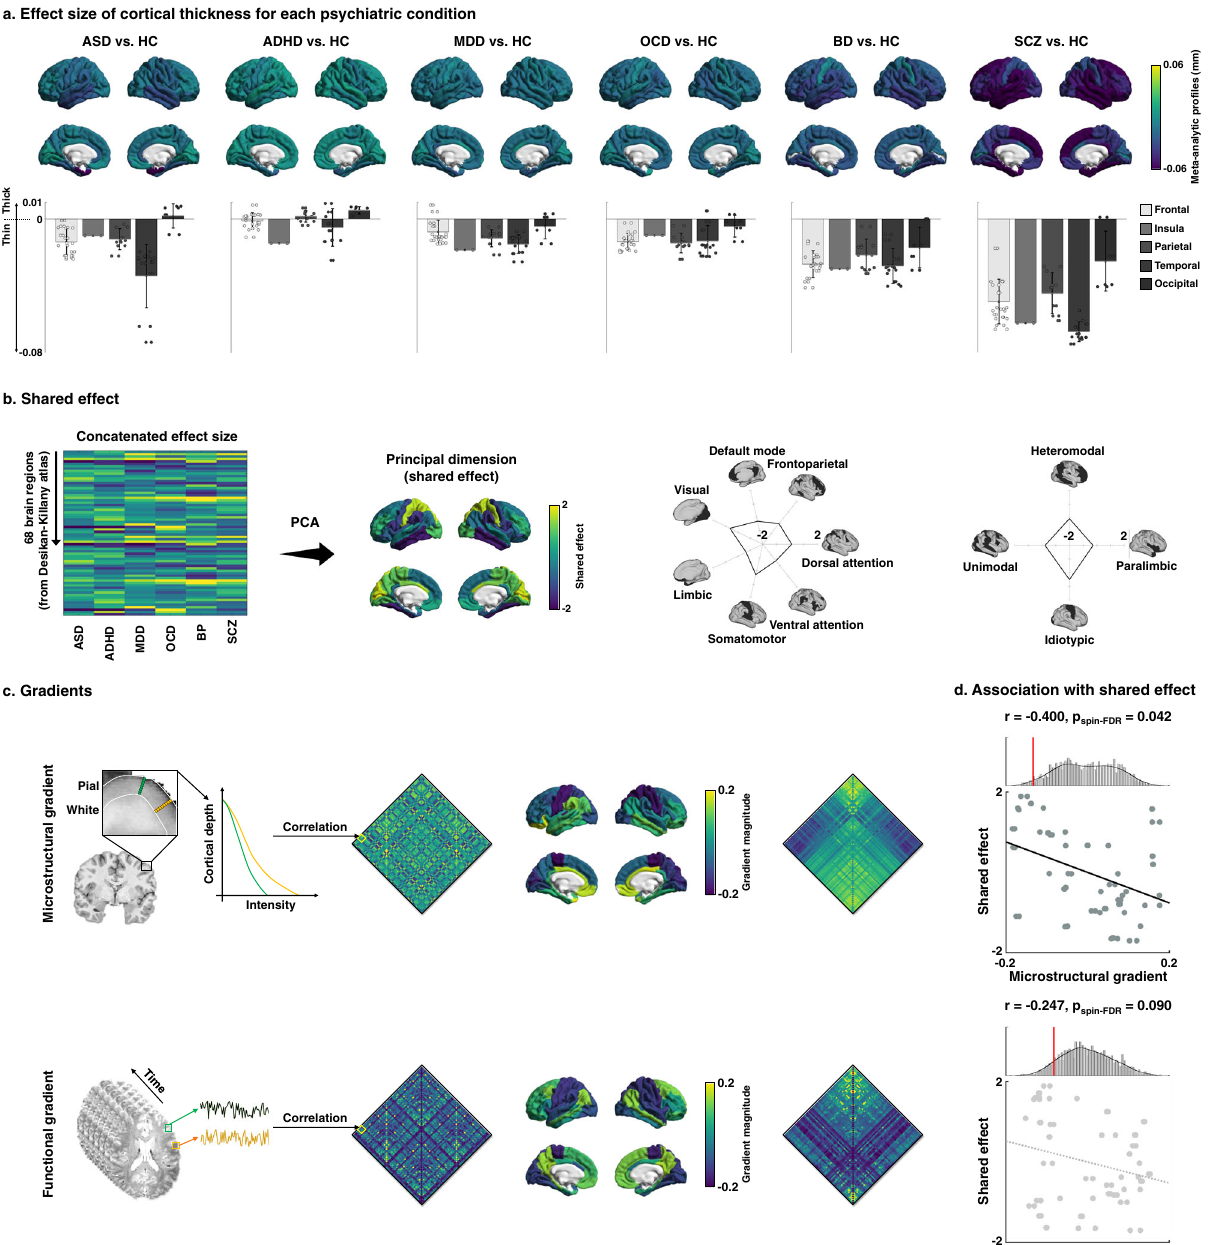
Fig. 1 Shared disease effect and associations to connectivity gradients. a Meta-analytic pro fi les of cortical thickness differences (unit in mm) in patients with each psychiatric condition relative to matched controls. Positive/negative values indicate increases/decreases in cortical thickness in patients relative to controls. Mean values of the regions involved in the same cortical lobes with SD are reported with bar plots. b The shared effect was identi fi ed through principal component analysis (PCA) applied to the concatenated effect size map. Spider/Radar plots stratify the effects according to functional communities 68 and cortical hierarchy levels 41 . c The microstructural and functional connectivity gradients were generated by applying nonlinear dimensionality reduction techniques to the group averaged connectivity matrix (middle left), and each connectivity matrix was reordered (right) according to the fi rst gradients (middle right). d Spatial correlations of each gradient with the shared effect map are shown in the scatter plots. The distribution of correlation coef fi cients across 1,000 spin-tests are reported with histograms, and the actual r -values are represented with red bars. ASD autism spectrum disorder, ADHD attention de fi cit hyperactivity disorder, MDD major depressive disorder, OCD obsessive-compulsive disorder, BD bipolar disorder, SCZ schizophrenia, HC healthy controls, spin-FDR spin-test followed by false discovery